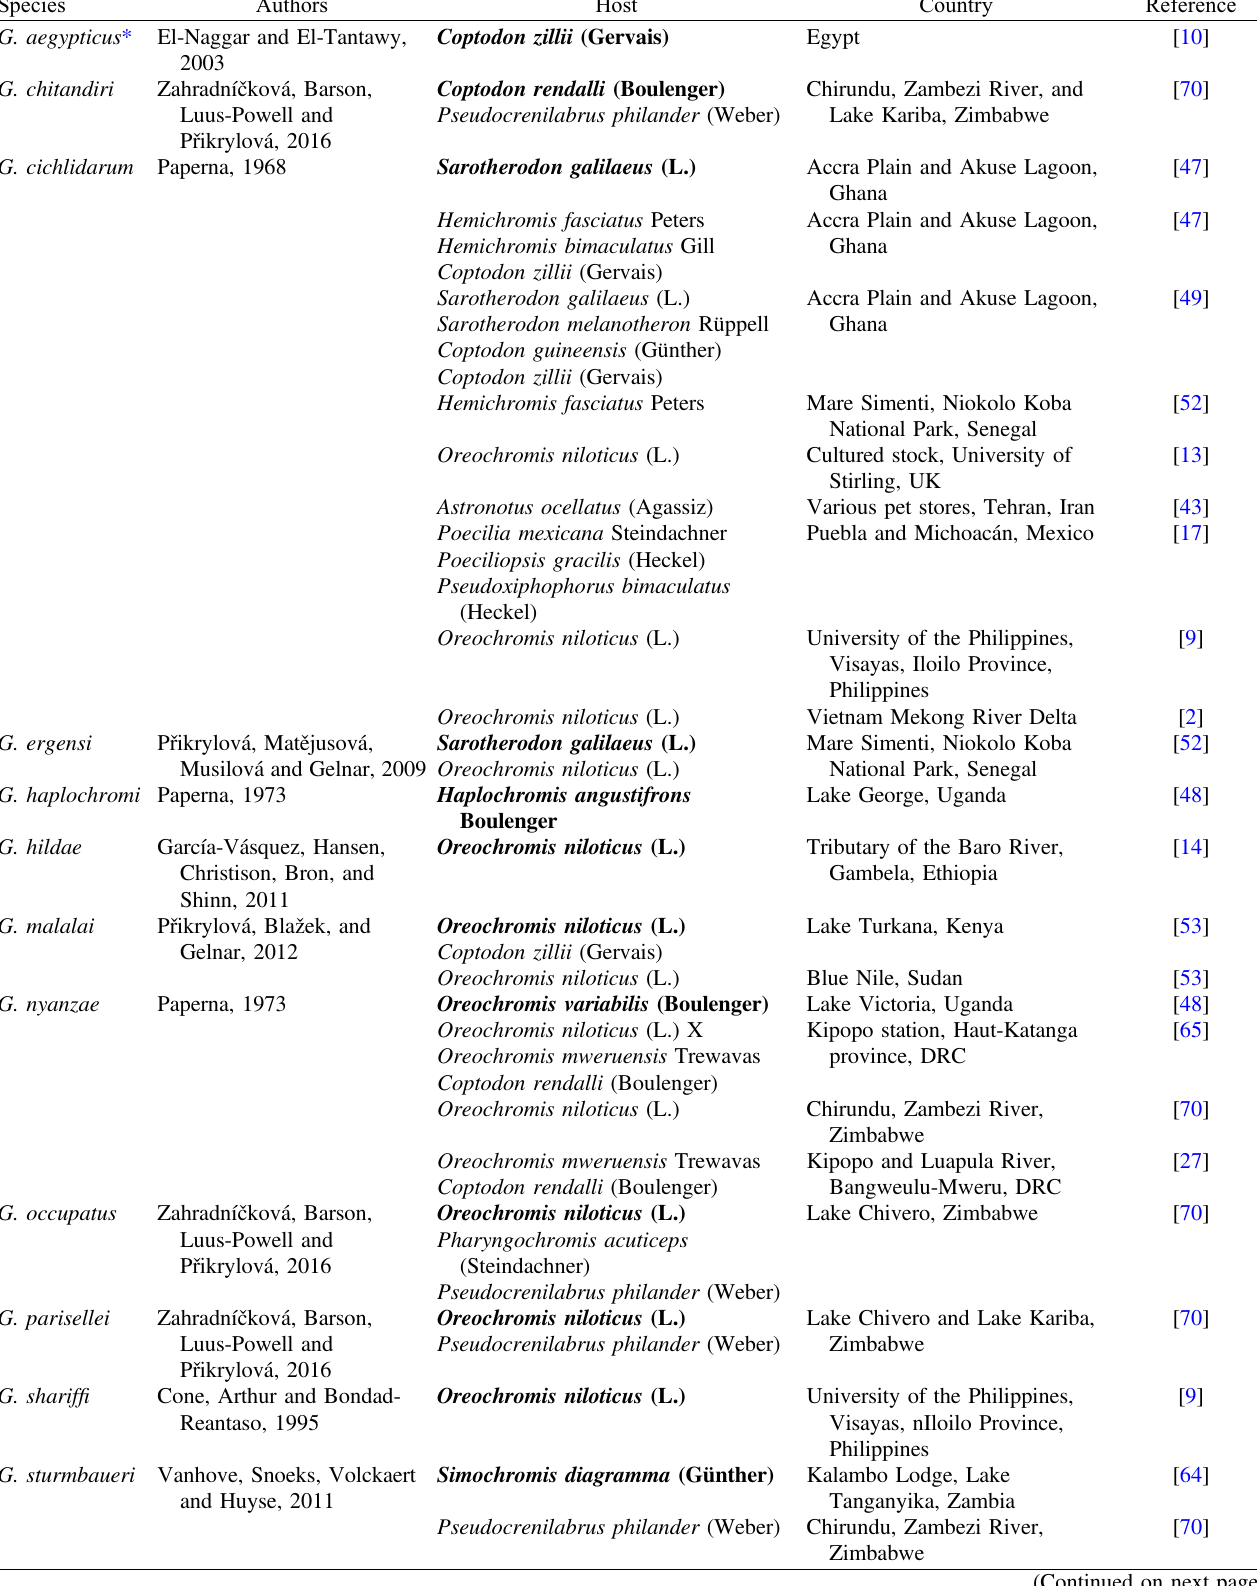
Table 1. Collection details, including author, host, and distribution, for all species of Gyrodactylus von Nordmann, 1832 described and recorded from African cichlids. Type hosts in